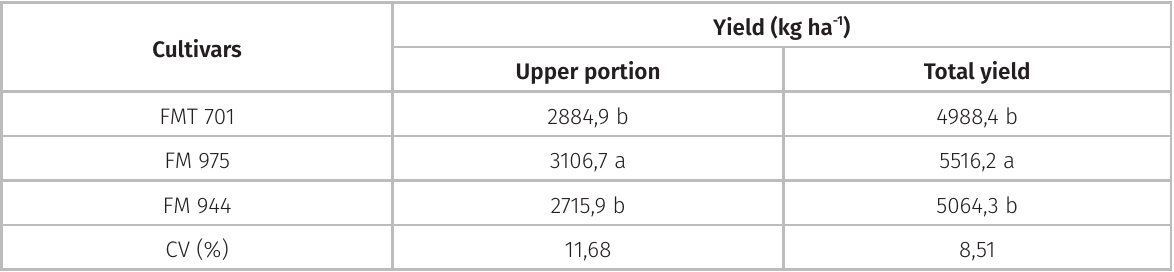
Table VI. Cotton seed yield (kg ha -1 ) in the upper portion and whole plant (total yield) of three cultivars. Chapadão do Sul, MS. Crop season 2014/15.